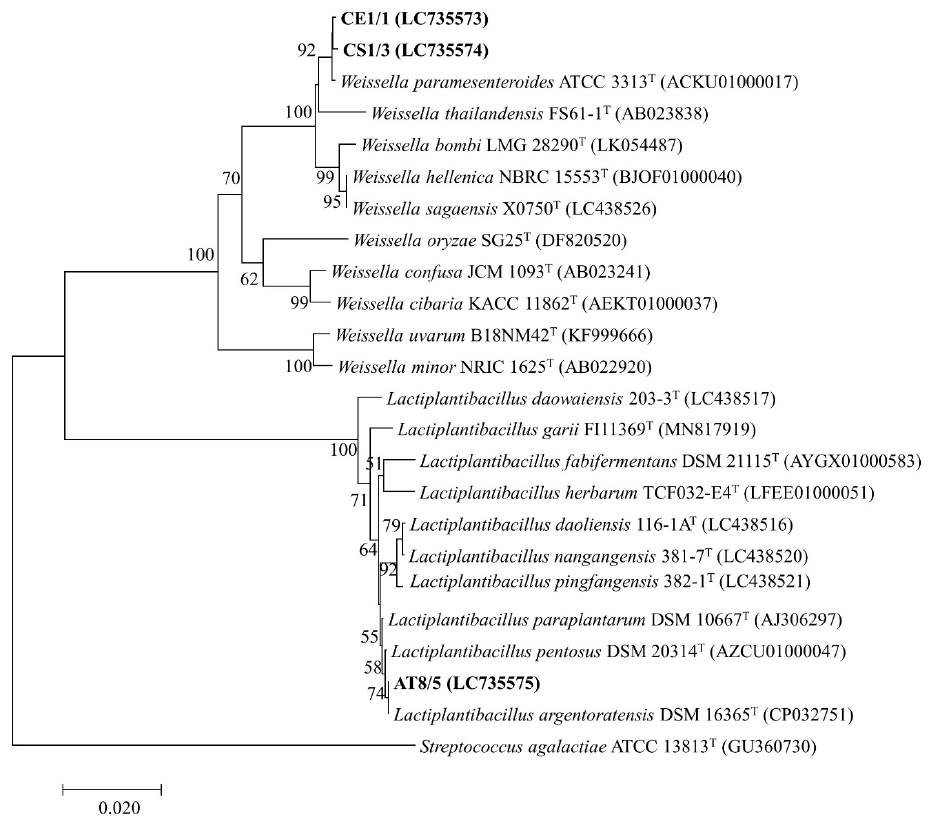
Figure 3. Phylogenetic tree constructed by the neighbor joining method based on 16S rDNA sequences indicating position of probiotic bacterial isolates. Streptococcus agalactiae ATCC 13813 T was used as an outgroup. Numbers at the nodes indicate bootstrap values based on 1000 replicates.